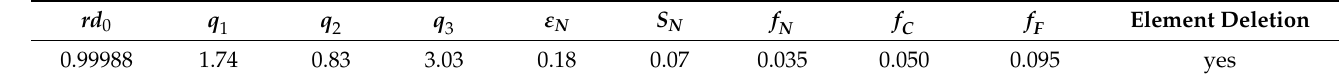
The contour plot predictions of the void volume fraction determined using the com- plete set of the GTN model parameters are shown in Figure 18a. Figure 18a depicts one of the experimental samples placed with the final predicted model shape. Moreover, the load–elongation curves showed similar results, see Figure 18b. The predicted curve is higher than the experimental data in the elongation range, close to the yielding point up to ~3 mm elongation. It may be attributed to the work-hardening